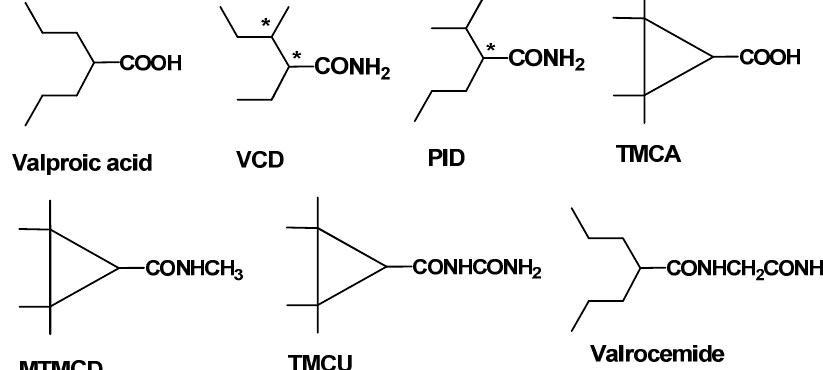
Figure 2. Structure of valproic acid and key 2 nd generation analogs. Chiral centers are denoted with an